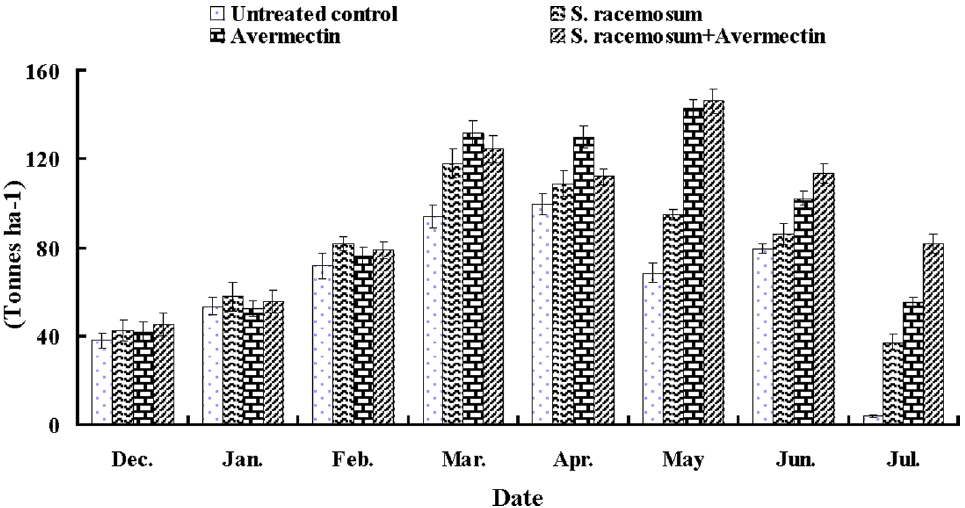
Figure 1. Final cumulative fruit yield per month of cucumber from December 2010 to July 2011 in the field experiment. Four experiments were designed in randomized blocks with untreated control, S. racemosum filtrate 10 ml m-2 ( S. racemosum ), 1.8% avermectin EC 3 ml m-2 (Avermectin) and S. racemosum filtrate 5 ml m-2 + 1.8% avermectin EC 2 ml m-2 ( S. racemosum + Avermectin).